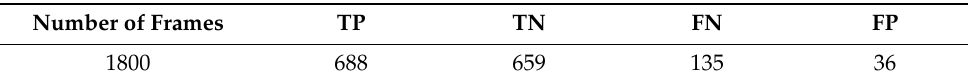
Figure 19. Detection accuracy timeline during inspection. Table 4. Accuracy